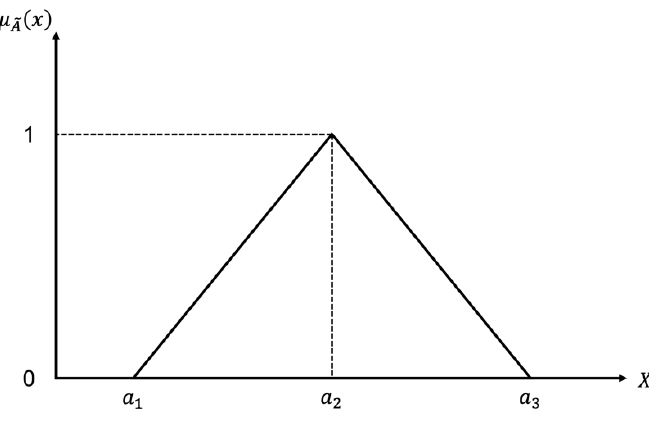
Figure 2. Fuzzy triangular number.